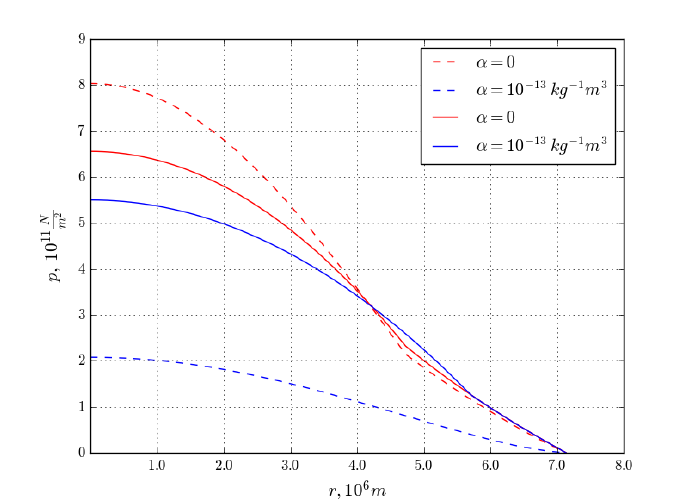
Figure 3. Relation between pressure and radius for Kepler-78 b exoplanet calculated analytically and numerically. The dashed line represents the numerical solution, whereas the solid line—analytical one. The curves are plotted for two different values of the parameter α = c 2 κ 2 β